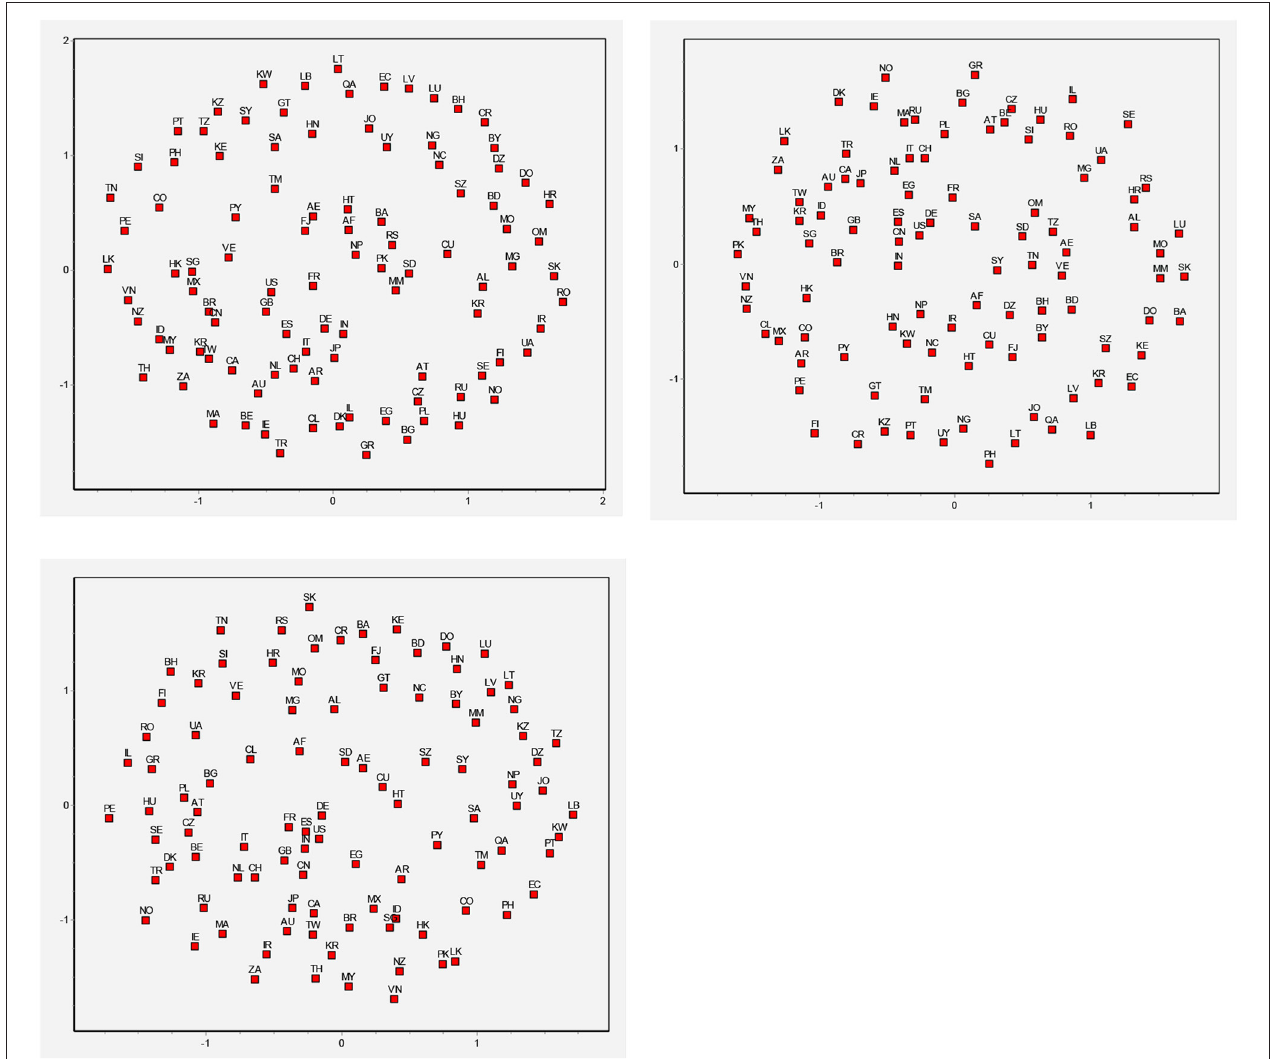
FIGURE 8 | MDS analysis for China in 2001, 2010, and 2020. Afghanistan, AF; Albania, AL; Algeria, DZ; Argentina, AR; Australia, AU; Austria, AT; Bangladesh, BH; Belarus, BD; Belgium, BY; Bosnia and Herzegovina, BE; Brazil, BA; Bulgaria, BR; Chile, BG; Columbia, CA; Costa Rica, CL; Croatia, CN; Cuba, CO; Czech Republic, CR; Denmark, HR; Dominican Republic, CU; Ecuador, CZ; Egypt, DK; Fiji, DO; Finland, EC; France, EG; Germany, SZ; Greece, FJ; Guatemala, FI; Haiti, FR; Honduras, DE; Hungary, GR; India, GT; Indonesia, HT; Ireland, HN; Israel, HK; Italy, HU; Kazakhstan, IN; Kenya, ID; Latvia, IR; Lithuania, IE; Luxemburg, IL; Madagascar, IT; Mexico, JP; Morocco, JO; Nepal, KZ; Netherlands, KE; New Caledonia, KR; Nigeria, KR; Norway, KW; Pakistan, LV; Paraguay, LB; Peru, LT; Philippines, LU; Poland, MO; Portugal, MG; Romania, MY; Russian Federation, MX; Slovakia, MA; Slovenia, MM; North Africa, NP; Spain, NL; Sri Lanka, NC; Sweden, NZ; Switzerland, NG; United Republic of Tanzania, NO; Tunisia, OM; Turkey, PK; Ukraine, PY; United Kingdom, PE; United States of America, PH; Uruguay, PL; Bolivarian Republic of Venezuela, PT; Bahrain, QA; Canada, RO; China, RU; Eswatini, SA; Hong Kong, China, RS; Islamic Republic of Iran, SG; Japan, SK; Jordan, SI; North Korea, ZA; South Korea, ES; Kuwait, LK; Lebanon, SD; Macau, China, SE; Malaysia, CH; Burma, SY; New Zealand, TW; Oman, TZ; Qatar, TH; Saudi Arabia, TN; Serbia, TR; Singapore, TM; Sudan, UA; Syrian Arab Republic, AE; Chinese Taipei, GB; Thailand, US; Turkmenistan (The Mirror), UY; United Arab Emirates, VE; Viet Nam, VN.